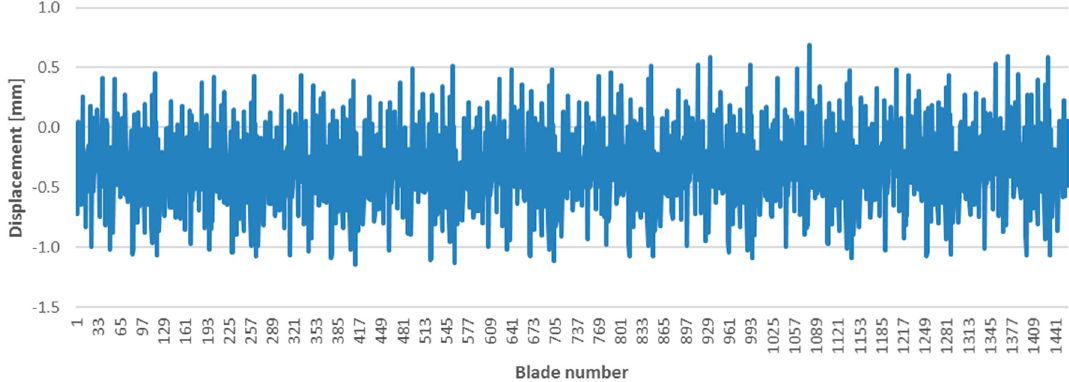
Figure 15. Displacement for 1460 blades (10 consecutive turns).